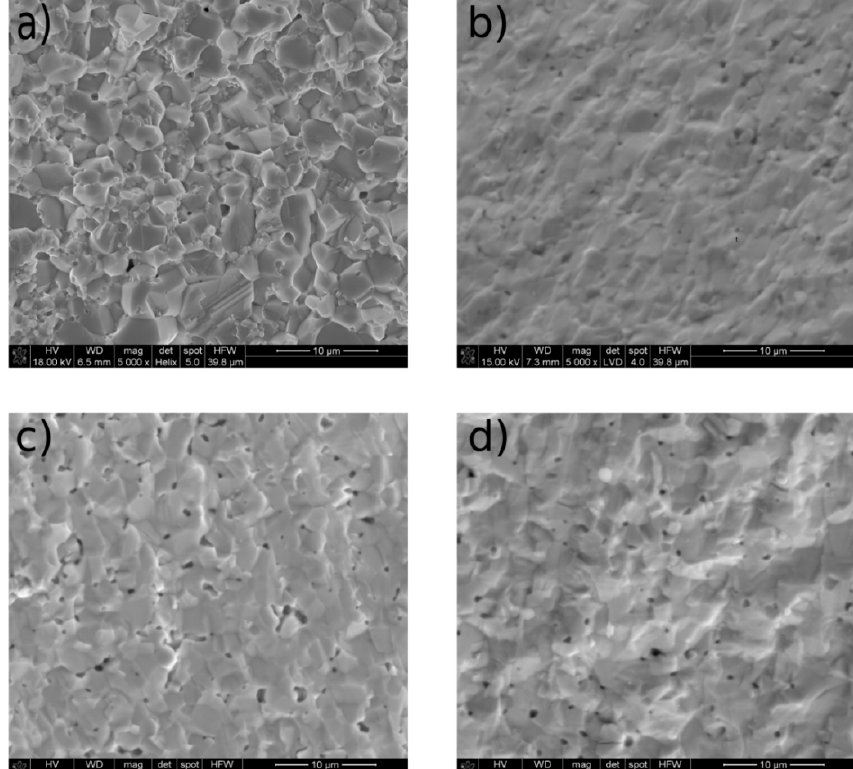
Figure 6. The microstructure of the representative surface of sintered ( a ) BCY, ( b ) 2SBCY, ( c ) 5SBCY, and ( d ) 10SBCY samples.